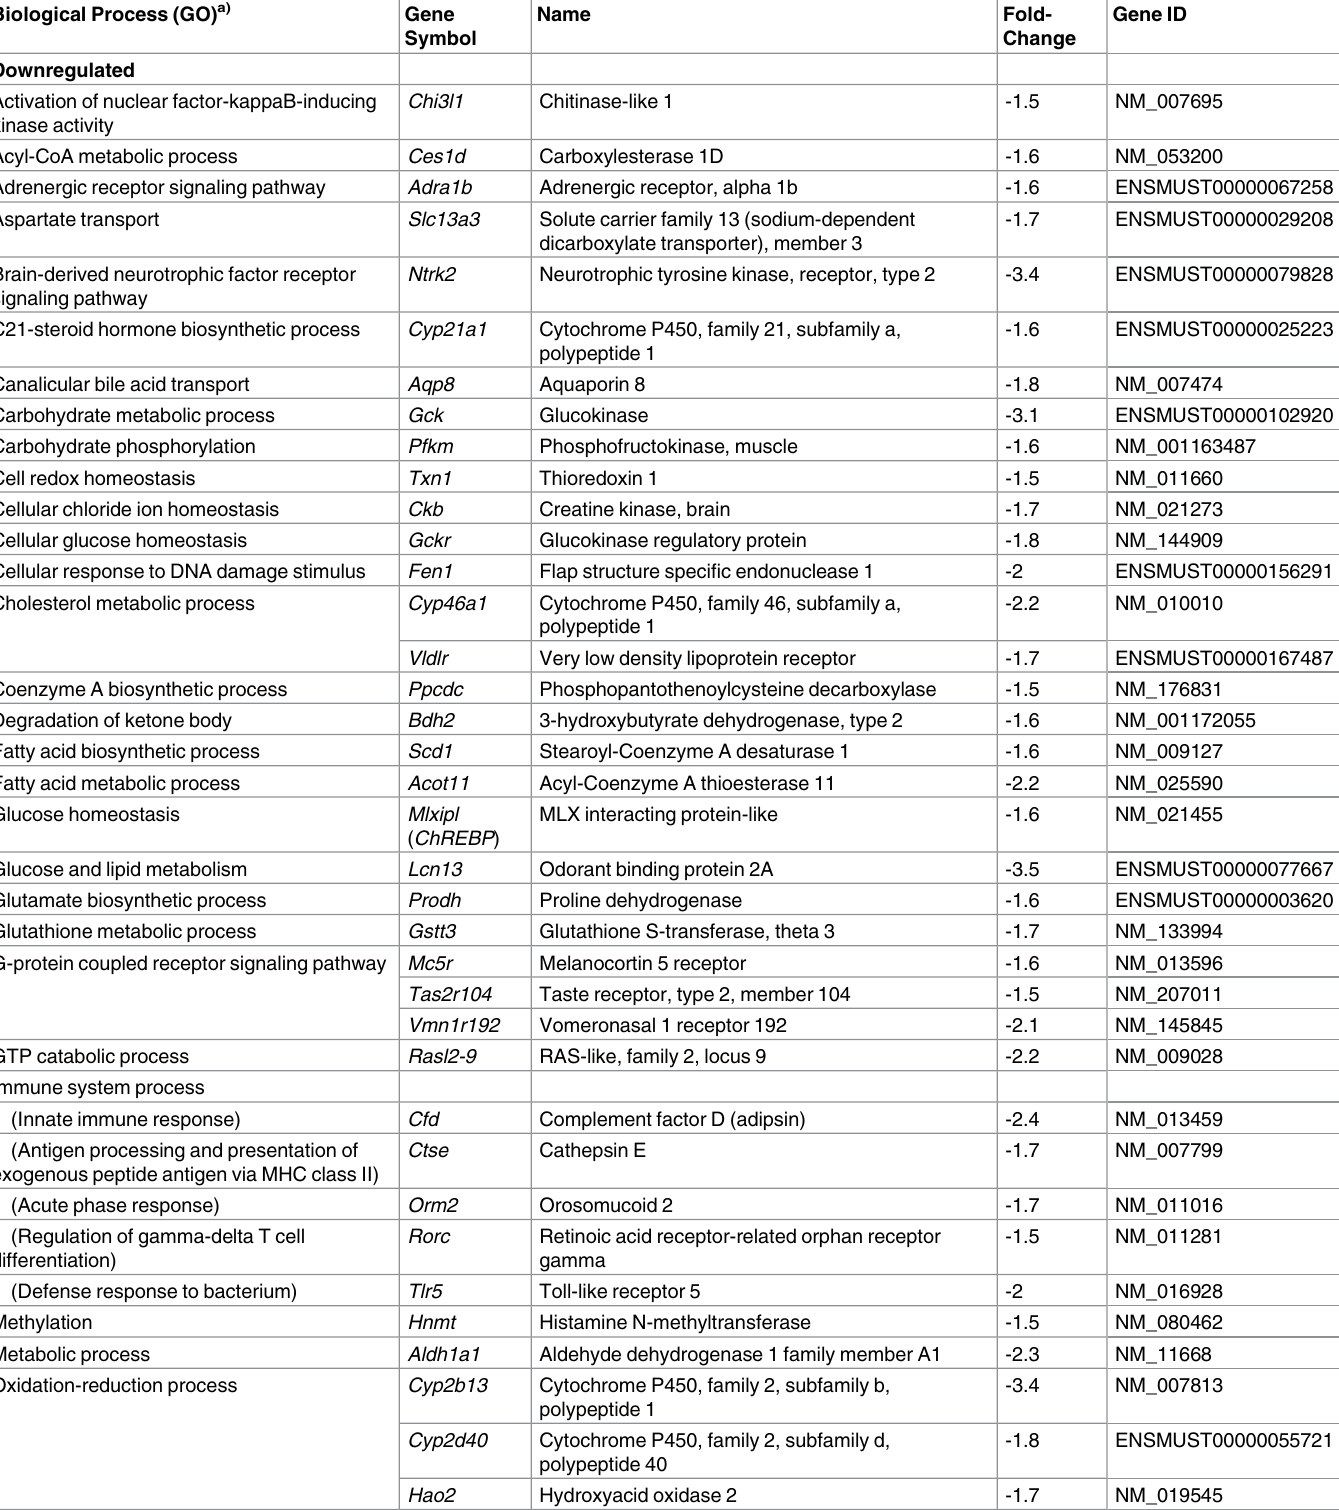
Table 4. Summaryof selected genes showing significant (cid:21) |1.5|-fold hepatic modulation in mice fed a HF diet supplemented with